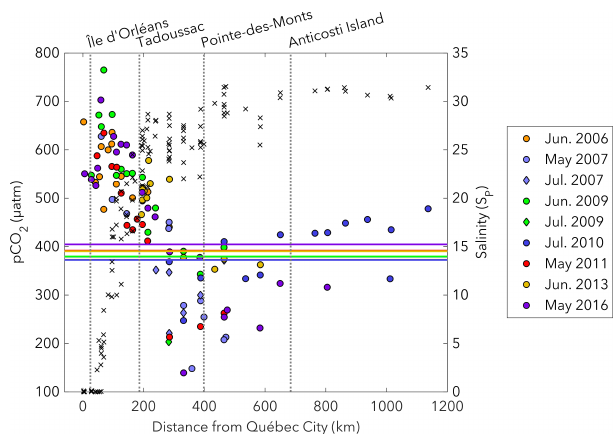
Figure 4. Spatial distributions of surface-water p CO 2 (circles, di- amonds) and practical salinity ( × symbols) in the St. Lawrence River, SLE, and GSL during spring and summer cruises. Horizon- tal lines show the mean p CO 2 (air) in the sampling months. The p CO 2 data points above atmospheric level are sources of CO 2 to the atmosphere, whereas those below atmospheric level are sinks of atmospheric CO 2